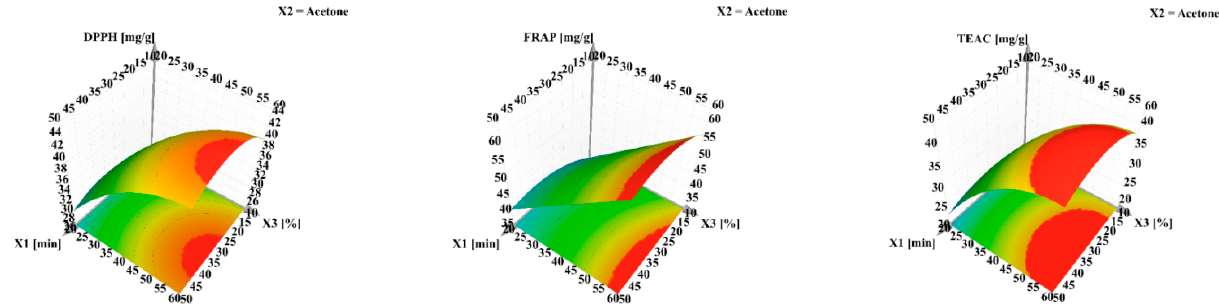
Figure 7. Response surface for predicting DPPH, FRAP and TEAC antioxidant activity in walnut flower extracts. X 1 —extraction time (min); X 2 —solvent (Acetone); X 3 —water in solvent (%, v/v ). The regions in red represent the domains of working conditions assuring the maximum extraction yield for the evaluated bioactive compounds.